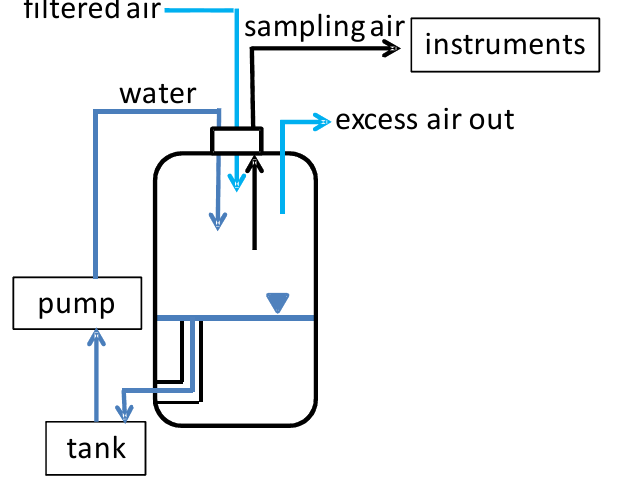
Fig. 2. Schematic picture of bubble bursting experimental setup. The tank was used as a buffer to recirculate the sea water sample trough the PET bottle, where SSA was produced by an impinging water jet. Darker blue lines represent water, and the triangle symbol indicates the water surface in the bottle.